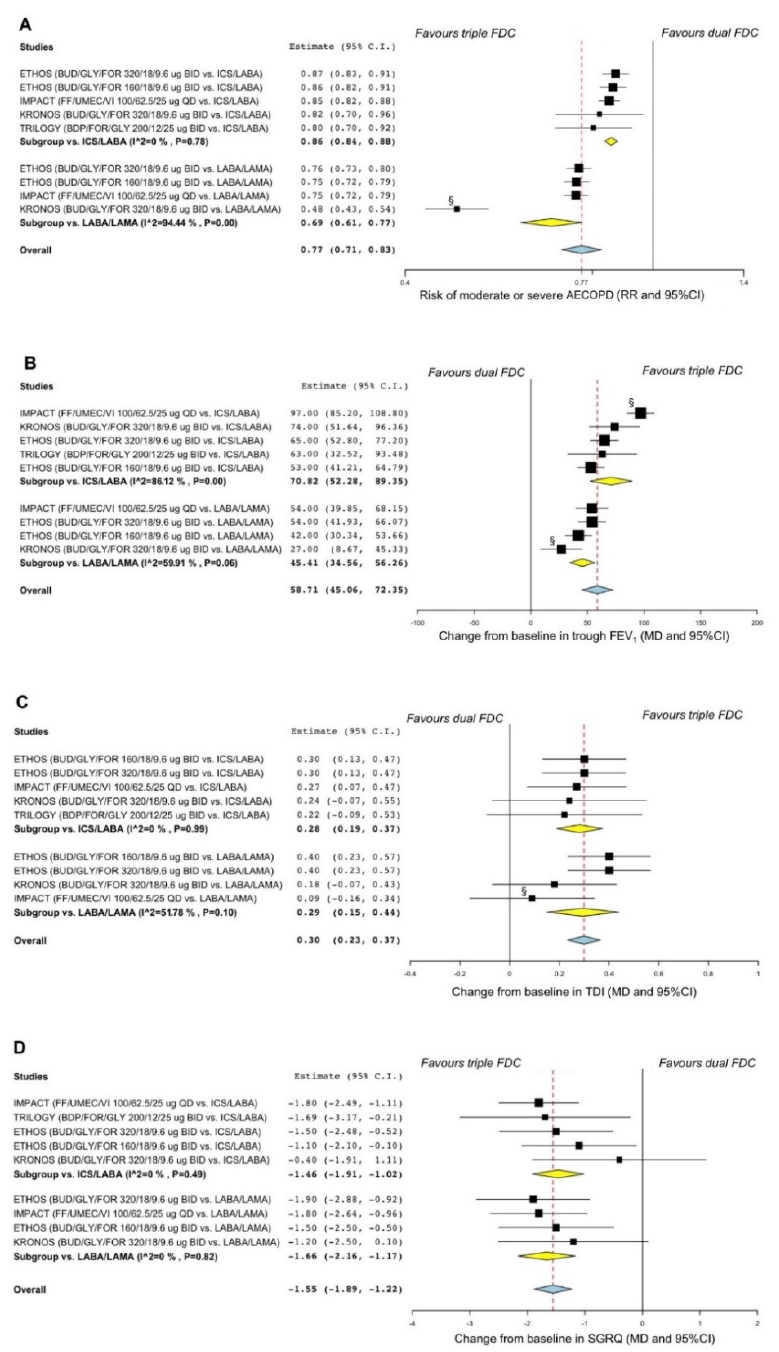
Figure 2. Forest plots of pairwise meta-analysis concerning the efficacy of triple ICS/LABA/LAMA FDCs vs. dual FDCs on the risk of moderate or severe AECOPD ( A ) and the change from baseline in trough FEV 1 ( B ), TDI ( C ), and SGRQ ( D ). § Treatment comparison introducing substantial heterogeneity in